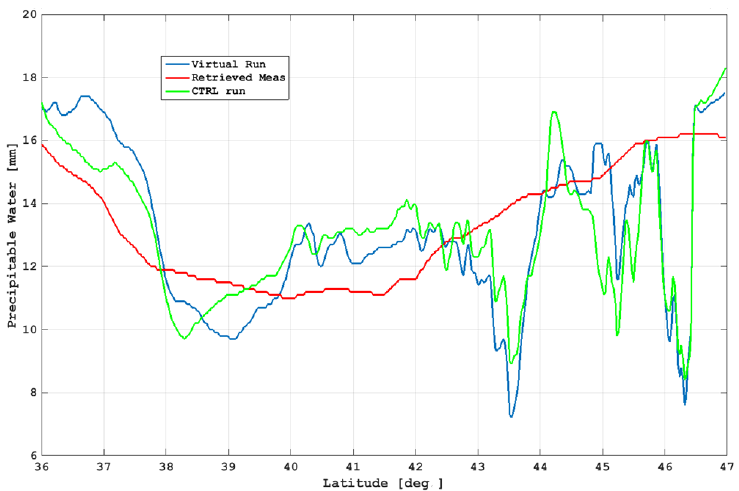
Figure A2. Case study of 24 September 2020, 18UTC: precipitable water values in [mm] as extracted on the transect at 11.25° E for VR (blue line), CTRL (green line), and retrieved measurements (red line).